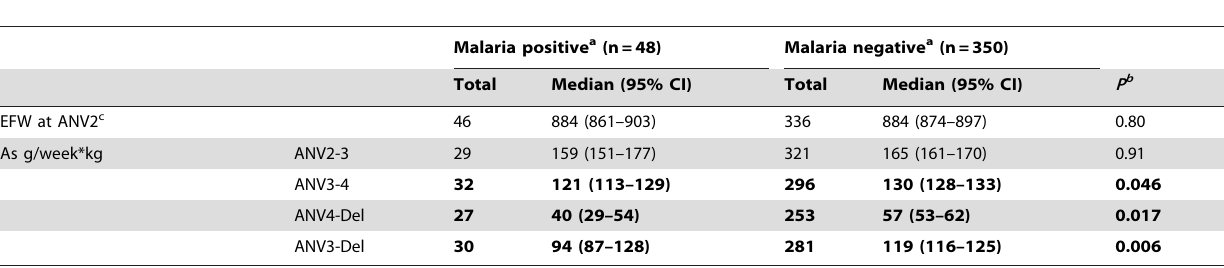
Table 3. The effect of malaria during pregnancy on fetal growth, given as relative fetal growth (g/week*kg), among primi- and secundigravidae.